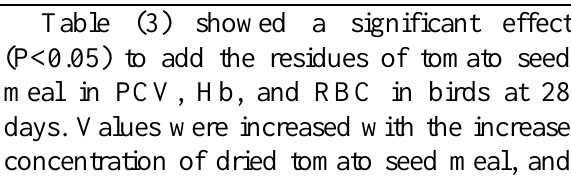
Table, 3: The effect of the addition residues of the tomato paste industry of some blood parameters of the broiler at the age of 28 days and 56 days. Treatment